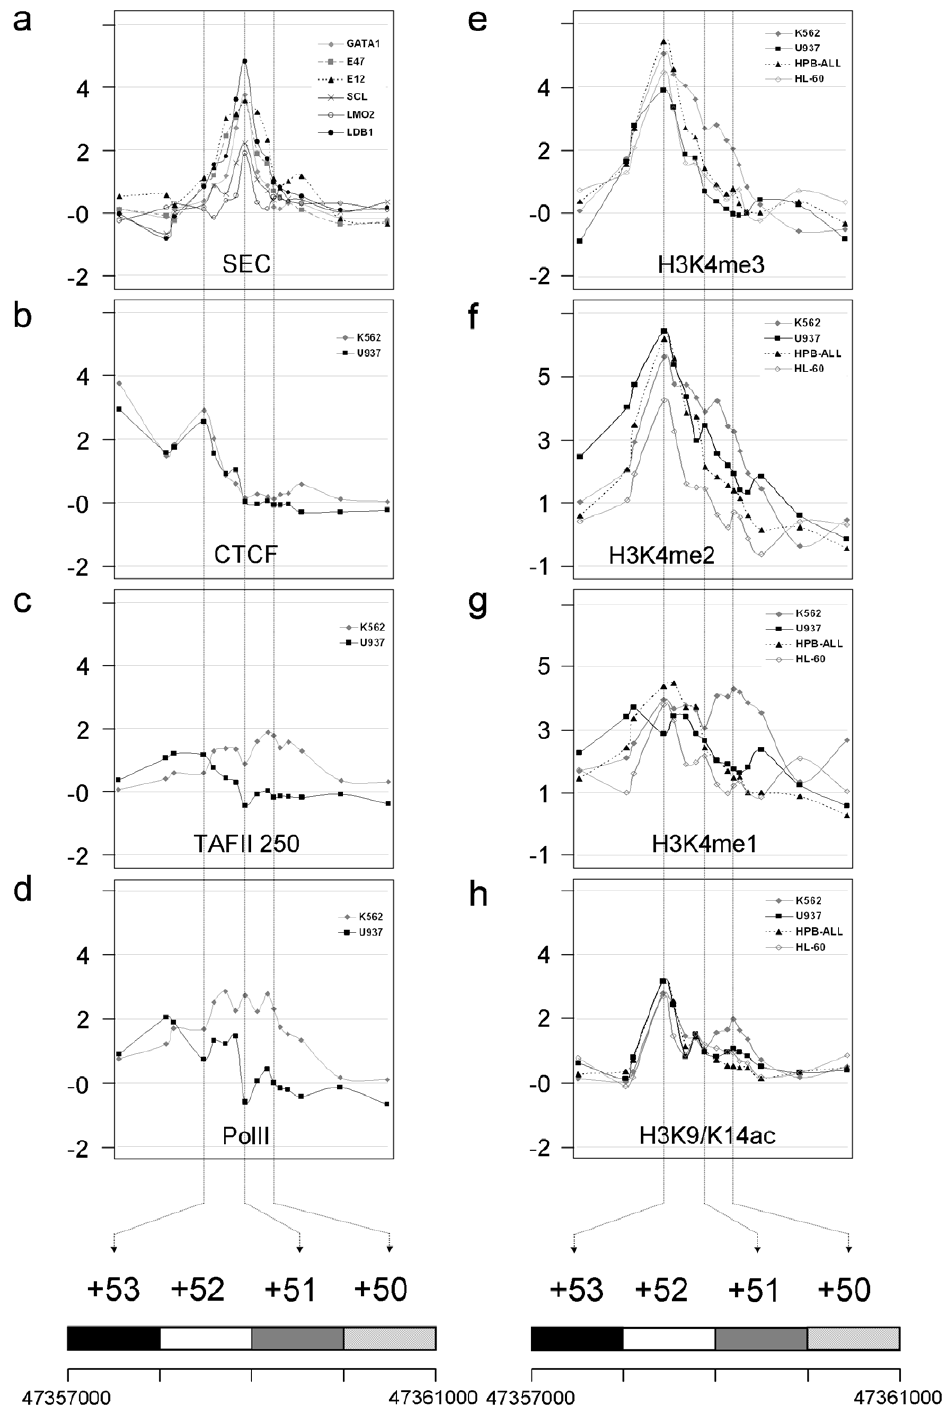
Figure 5. ChIP-chip analysis of the human SCL erythroid enhancer region in SCL-expressing and non-expressing haematopoietic cell lines. A. Binding of the SCL-containing erythroid complex (SEC) of transcription factors in the K562 cell line. E47 and E12 are two isoforms of E2A. B. CTCF binding in the K562 and U937 cell lines. C. TAFII 250 binding in the K562 and U937 cell lines. D. PolII binding in K562 and U937 cell lines. E. Histone H3 K4me3 in the K562, U937, HPB-ALL and HL-60 cell lines. F. Histone H3 K4me2 in the K562, U937, HPB-ALL and HL-60 cell lines. G. Histone H3 K4me1 in the K562, U937, HPB-ALL and HL-60 cell lines. H. Histone H3 K9/K14ac in the K562, U937, HPB-ALL and HL-60 cell lines. All enrichments obtained in ChIP-chip assays are expressed in log 2 scale in the figure. Schematic at the bottom shows the 4 kb of genomic DNA surrounding the SCL erythroid enhancer. Genomic sequence co-ordinates are from NCBI build 35. Numbering of the blocks of DNA (with dotted lines through all the panels) refers to the distance in kb from SCL pro1a. The vertical dotted lines are positioned at the mid-point of each of the 1kb blocks and do not define positions of regulatory regions per se .